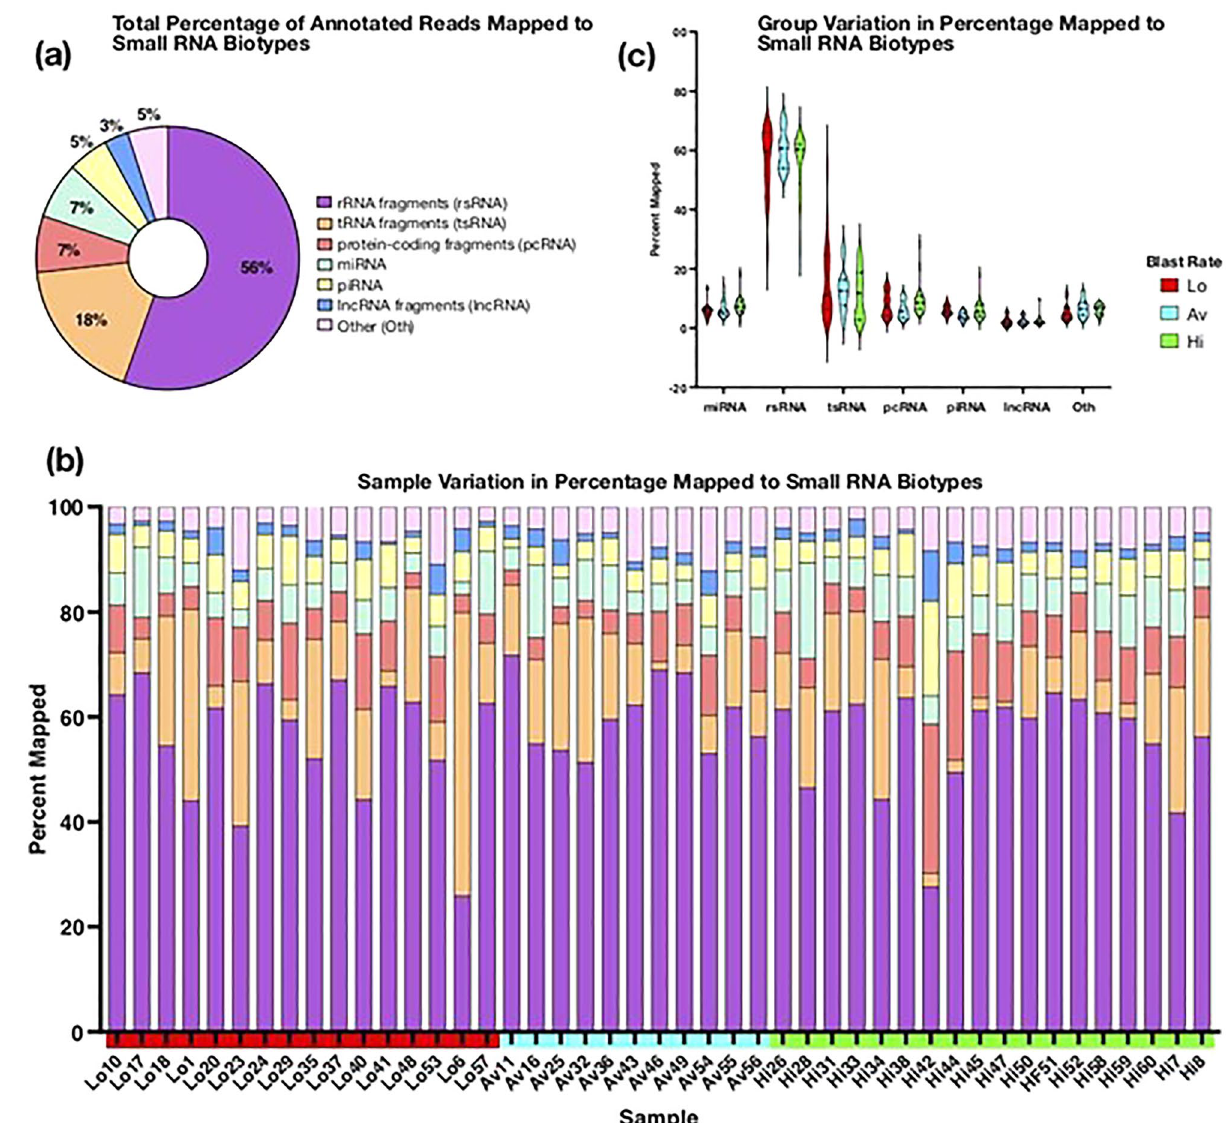
Figure 1. Categories of small RNAs identified. (a) Small RNA biotypes as a percentage of the total annotations. Small RNAs represented within ‘other small RNA,’ include miscellaneous coding and non-coding small RNAs, such as small nuclear RNA (snRNA) and mitochondrial genomic RNA. Both human miRNAs and sequences mapped to other miRNAs are included. (b) Small RNA biotype distribution across individual samples. The percentage of annotations mapped to rRNA fragments (mean = 57%; SD = 10%), tRNA fragments (mean = 14%; SD = 11%), miRNAs (mean = 7%; SD = 3%), piRNAs (mean = 6%; SD = 3%), protein-coding fragments (mean = 8%; SD = 5%), lncRNAs (mean = 2%; SD = 2%) and other small RNAs (mean = 6%; SD = 2%) are relatively uniform across samples, though tRNA and rRNA fragments demonstrate the highest variability. Hi, Av, and Lo refer to sample groupings (high, average and low, respectively), as indicated by blastocyst development rates. (c) Comparing Small RNA biotype distributions across the Hi, Lo, and Av groups. No significant differences in the mean biotype proportions for each blastocyst rate group were identified. A one-way ANOVA was used to compare